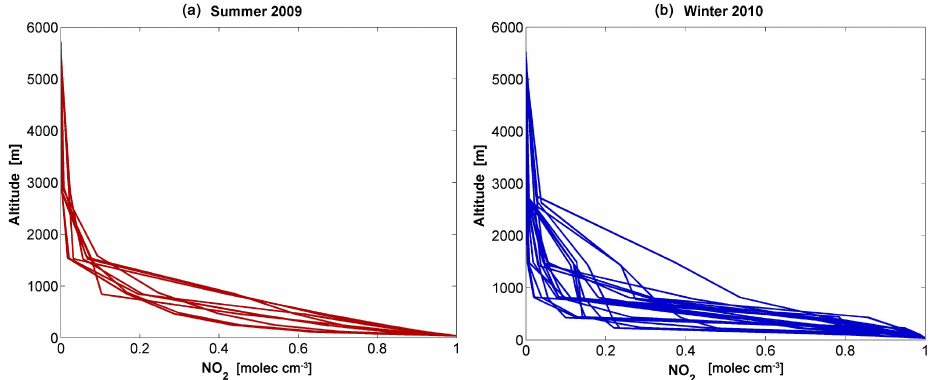
Figure A2. Daily CHIMERE NO 2 profiles (normalised by the surface values) for summer (a) and winter (b) extracted for the locations where the maximum NO 2 VCDs were measured by car